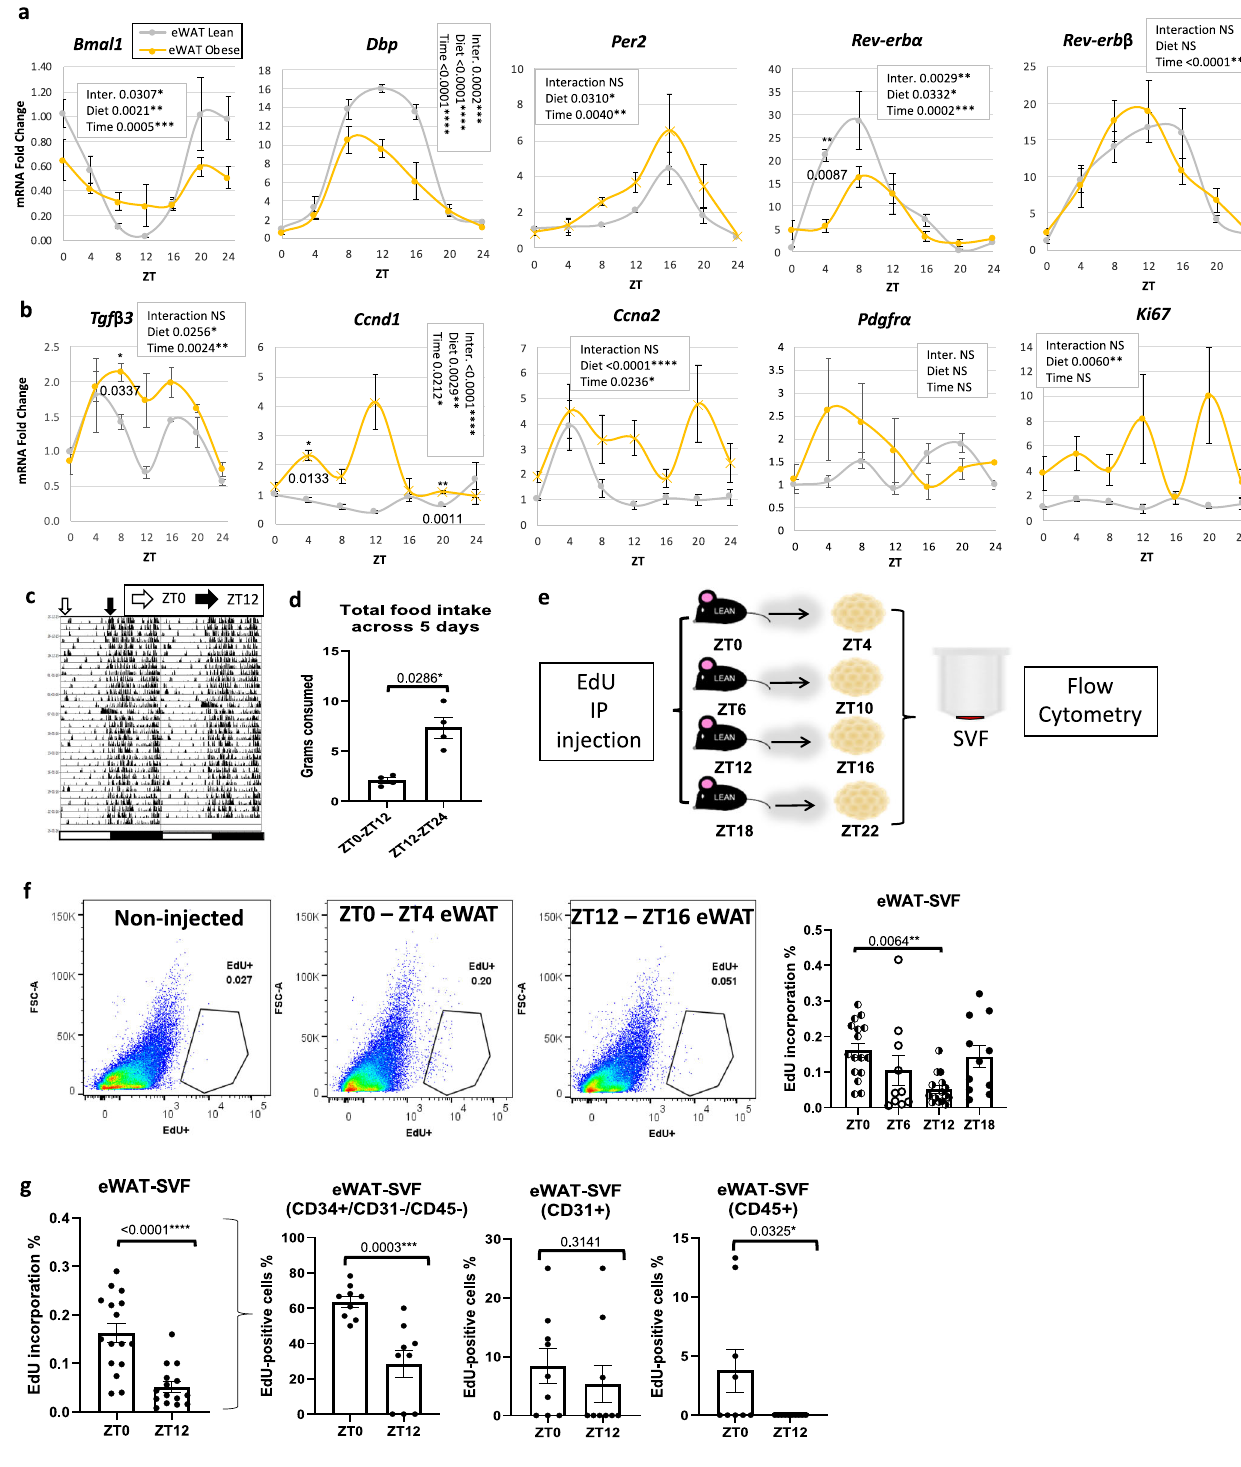
injections of 5-ethynyl-2 ʹ -deoxyuridine (EdU), which gets incorporated into DNA during the process of cell division. Though a single injection of EdU produced signi fi cantly less EdU-positive SVFs than 3 consecutive days of single injections at ZT0 in separate cohorts of lean mice (Fig. S1c), a single injection SVF proliferation in vivo. To test for rhythmic proliferation of